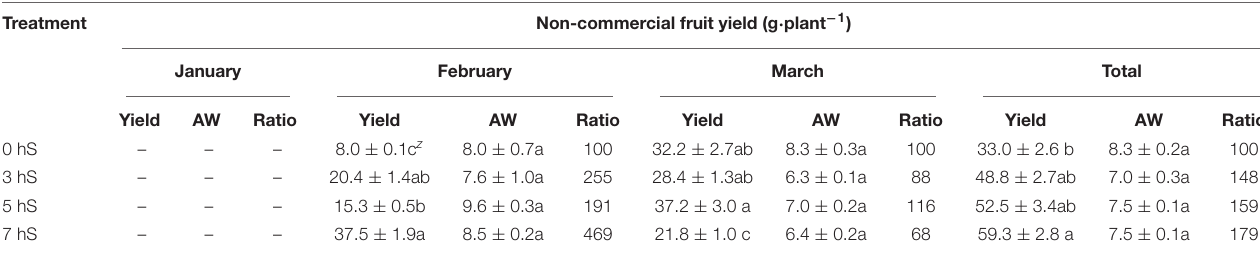
TABLE 2 | Non-commercial fruit yield of strawberry ( Fragaria × ananassa ) grown under various light intensity conditions in a smart greenhouse. Treatment